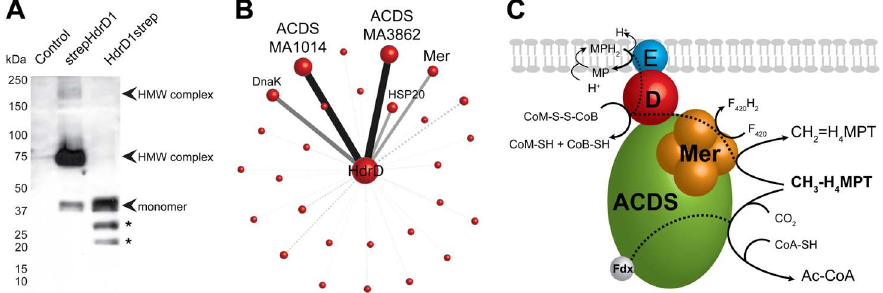
Figure 3. XL-MS identification of a multienzyme complex in Methanosarcina . A , Detection of HdrD complexes. 2 m g crosslinked cell lysates from controls or strains expressing strep-tagged HdrD1 protein were analyzed by Western blot. Arrows indicate the position of strep-tagged HdrD1 monomer and crosslinked high molecular weight (HMW) complexes. *=degraded HdrD1strep protein. B , HdrD co-purified proteins detected by mass spectrometry. Node sizes, line opacity and line widths are proportional to the average peptide hit score of the protein detected in biological duplicates. Dotted lines denote an average score below 100, solid lines denote an average score of 100 and above. Image created with Cytoscape [36]. C , Putative model of the Hdr:ACDS:Mer complex. During methylotrophic growth, both ACDS and Mer use methyl-H 4 MPT as a substrate. Black dotted lines=electron flow between active sites. HdrE (blue) or HdrD (red), Mer is a tetramer (orange), and ACDS is composed of 5 subunits in a ( a 2 e 2 ) 4 b 8 ( cd ) 8 configuration (green) [13,16,37]. doi:10.1371/journal.pone.0107563.g003 PLOS ONE |